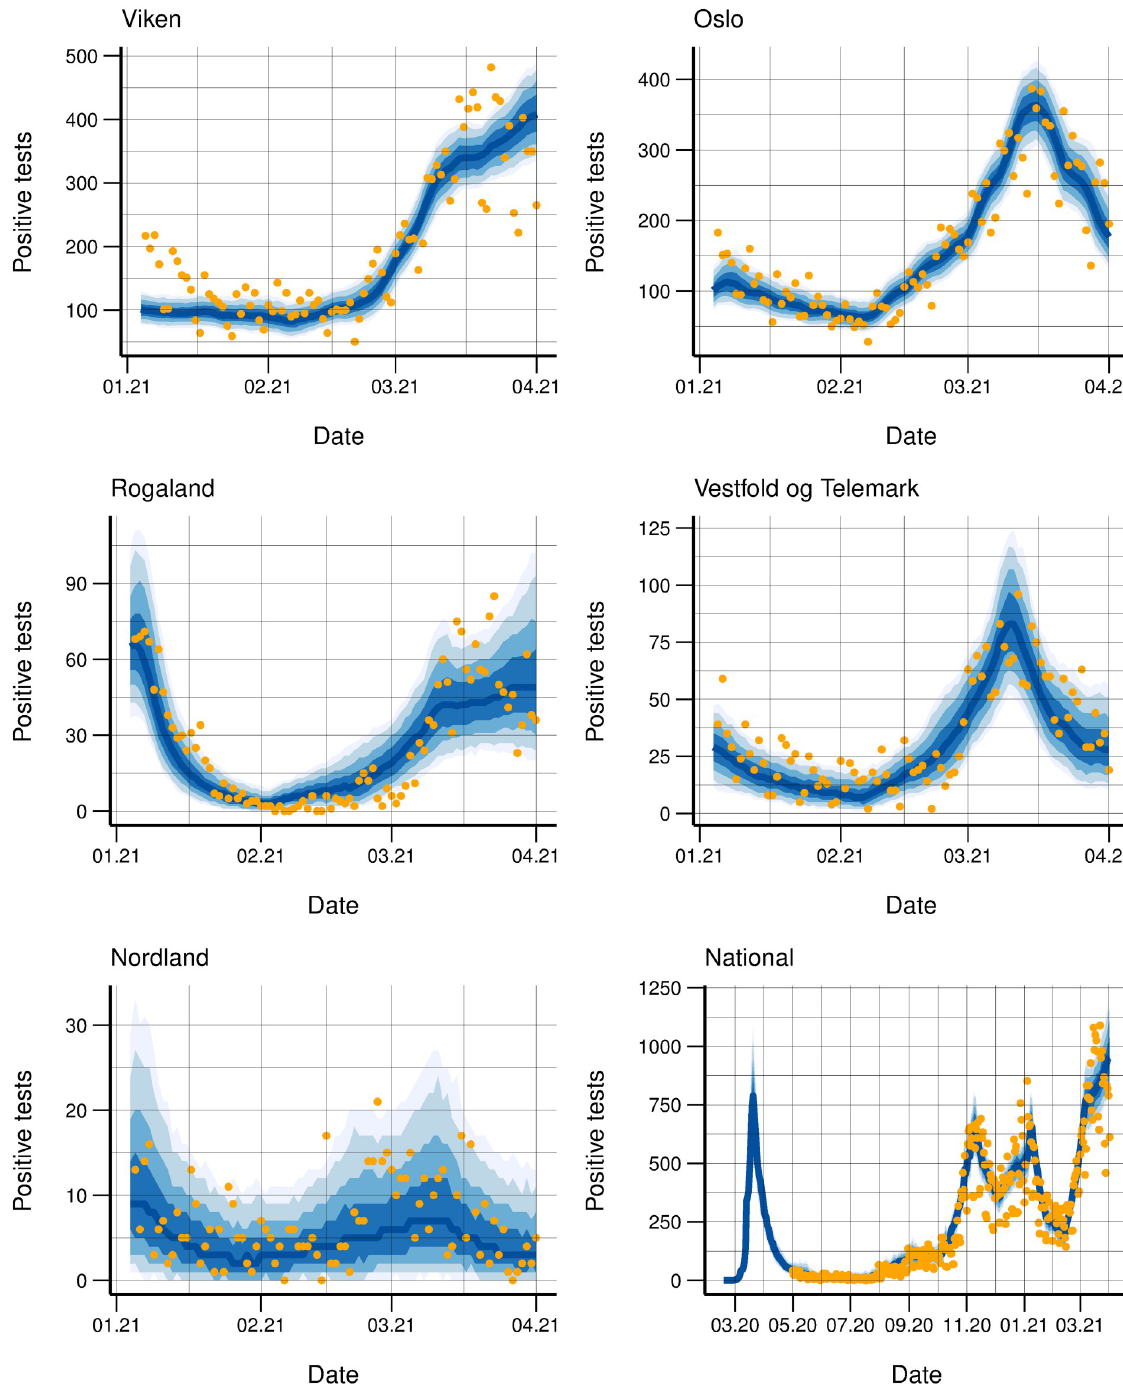
Fig 4. Test data fit. Observed daily (orange dots) and simulated (blue bands) laboratory-confirmed cases January to April, 2021 for five counties and nationally March 2020 to April 2021. The bands correspond to 50, 75, 90 and 95% credibility